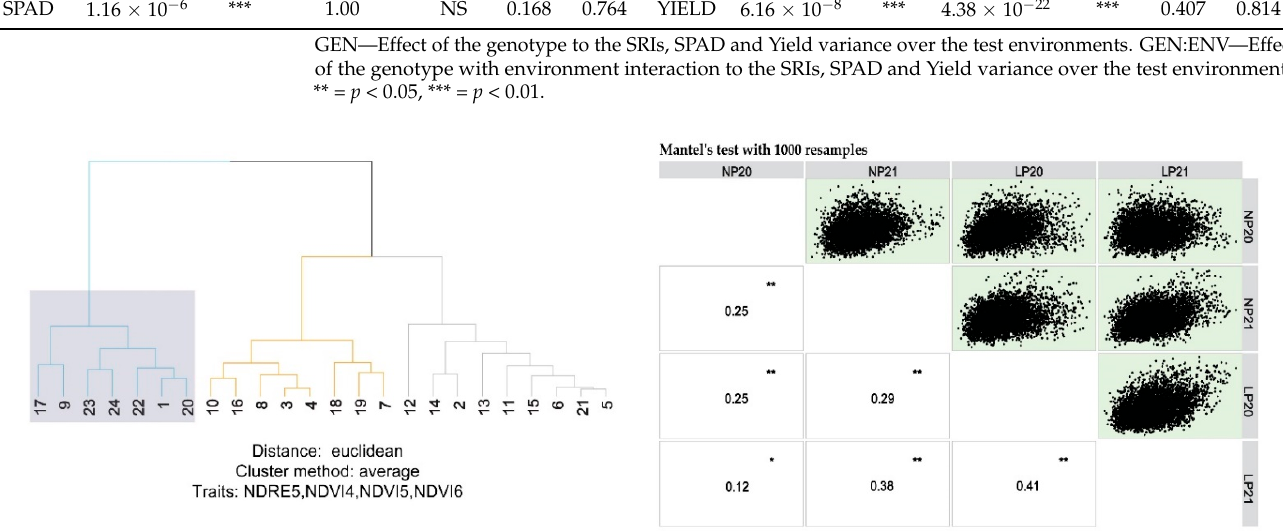
Figure 7. Dendrogram of the agglomerative hierarchical clustering for the 24 sesame genotypes based on selected vegetation indices (NDRE5, NDVI4, NDVI5, NDVI6) ( left ). Mantel’s test correlation values among planting dates and years ( right ). * = p < 0.05, ** = p < 0.01